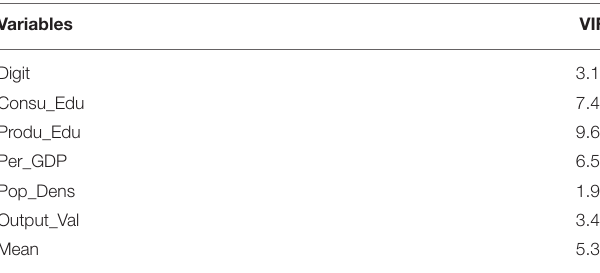
TABLE 3 | Variance inflation factor test.